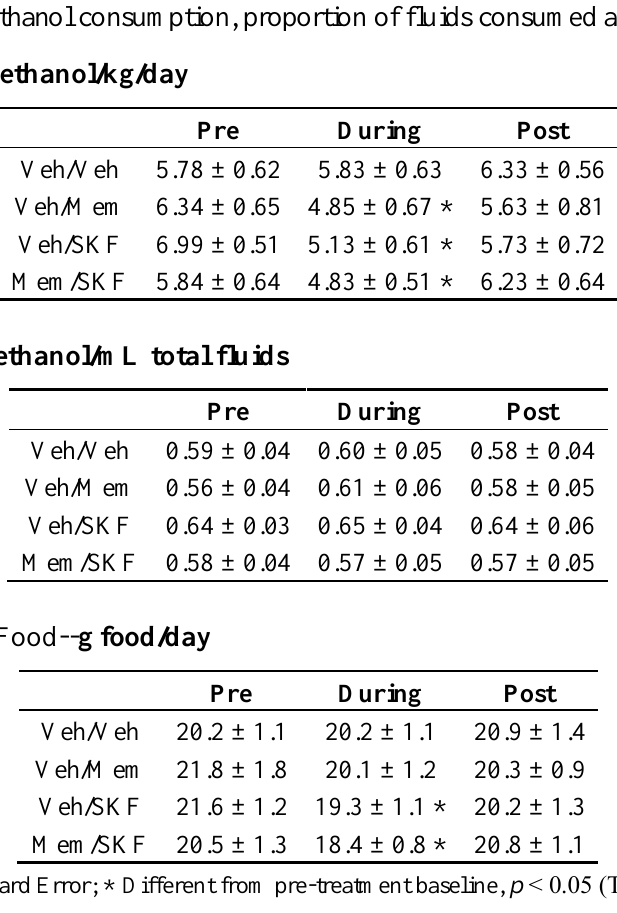
Table 1. Effects of 2.5 mg/kg SKF-38393, 1.0 mg/kg memantine, or in combination b.i.d. for three days on daily ethanol consumption, proportion of fluids consumed and food